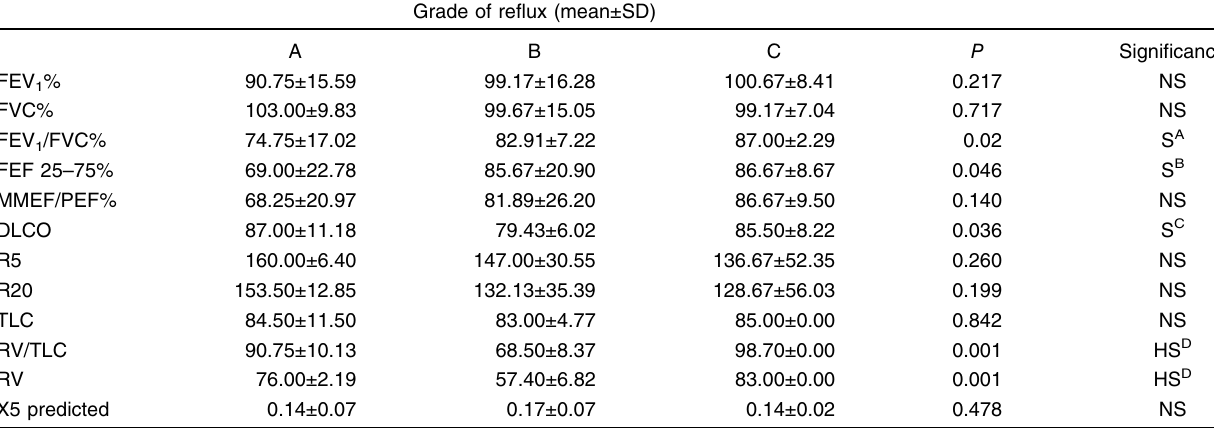
Table 4 Comparison between cases with different grades of reflux as regards PFT parameters Grade of reflux (mean±SD) A B C P Significance